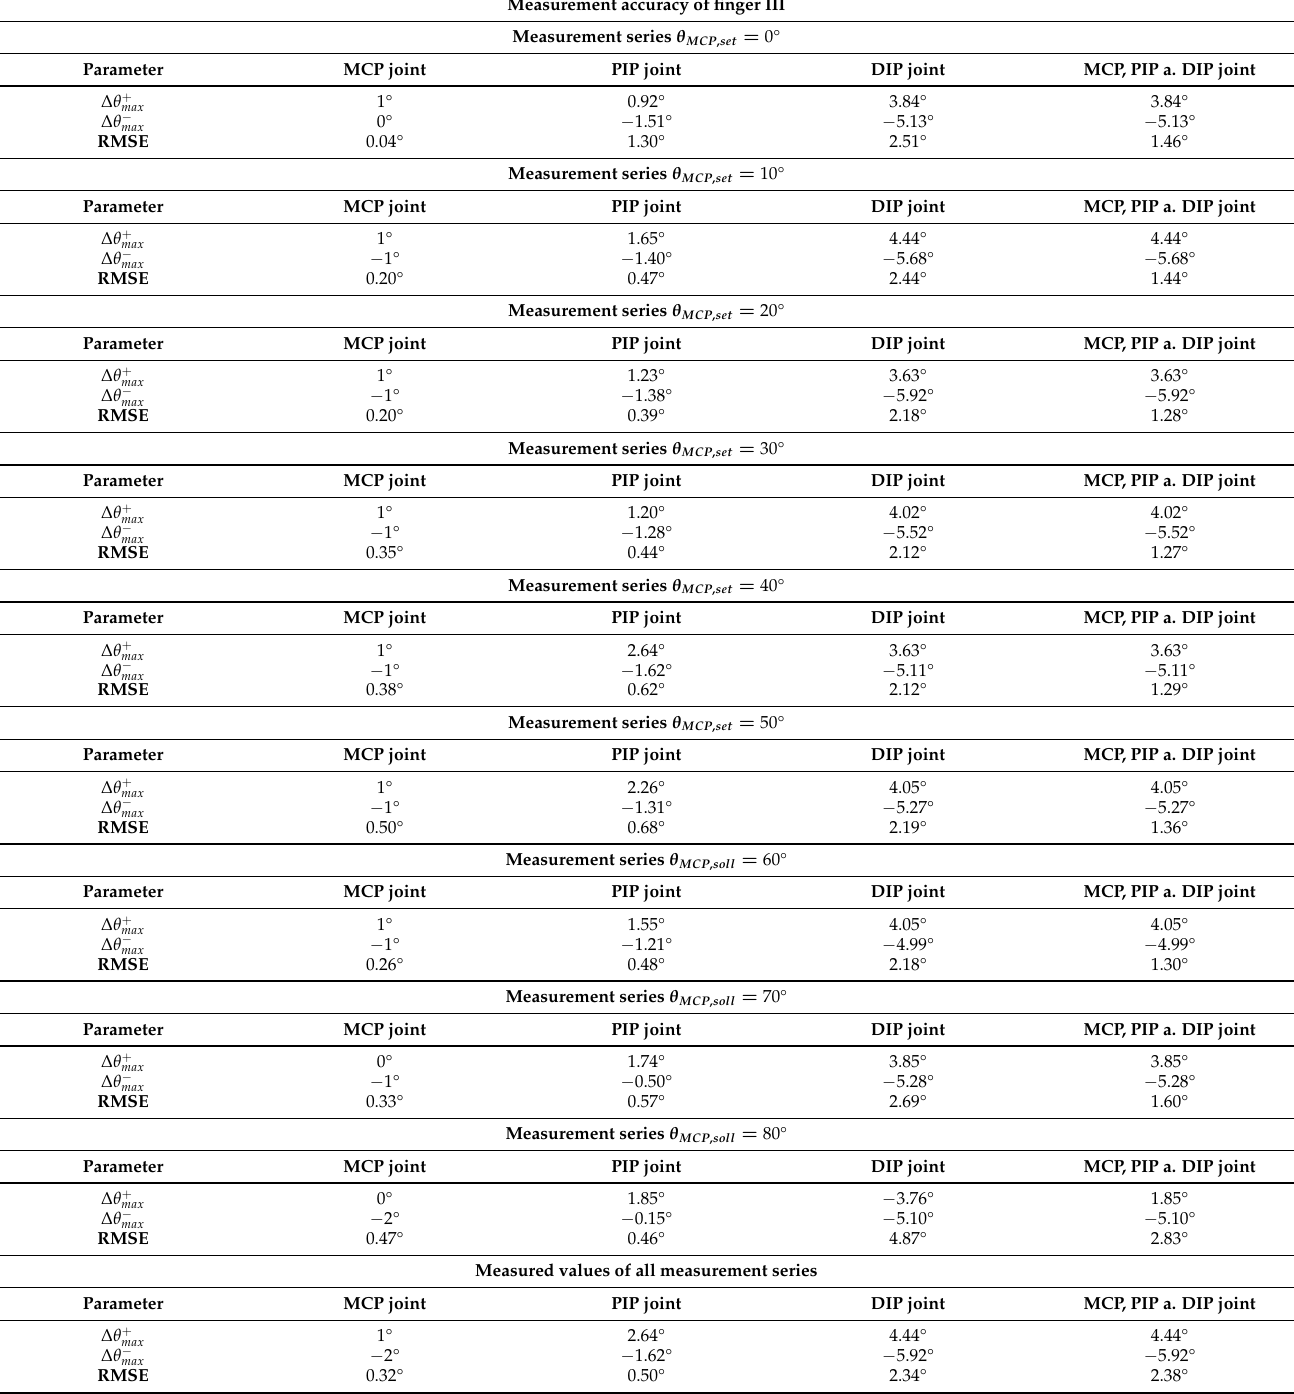
Table A10. Results of the measurement series on the measurement accuracy of the joint angles of finger III. Measurement series sorted in dependence on the predetermined angle θ MCP , set for the Metacarpophalangeal joint. Results shown are the maximum positive ∆ θ + max and negative ∆ θ − max deviations, as well as the root-mean-square error (RMSE). Joints: Distal Interphalangeal (DIP), Metacar- pophalangeal (MCP), Proximal Interphalangeal